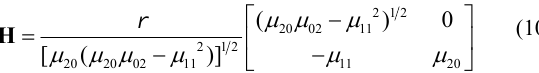
Fig.5 Schematic diagram of the proposed method